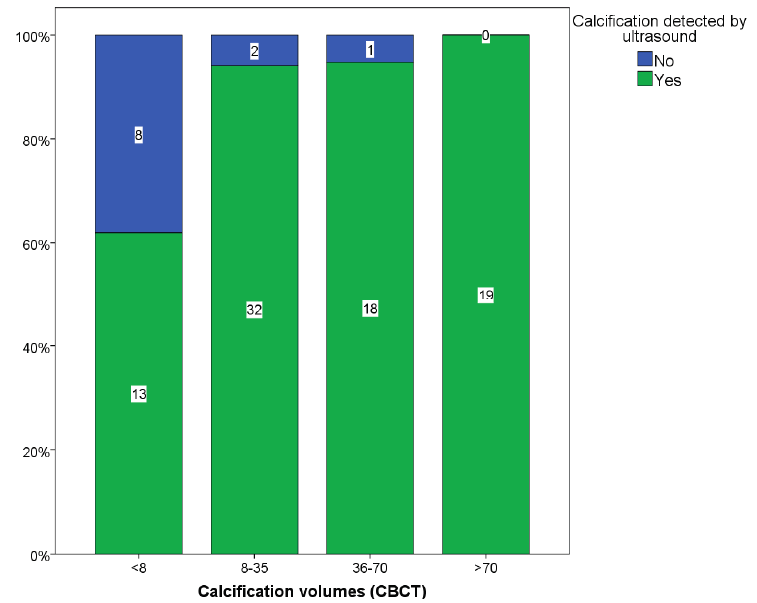
Figure 1. Quartiles of calcification volumes detected and not detected by